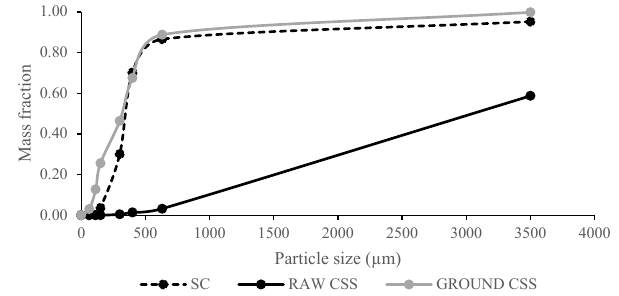
Figure 2. Sieves’ cumulative particle size distribution for raw CSS, ground CSS, and SC.